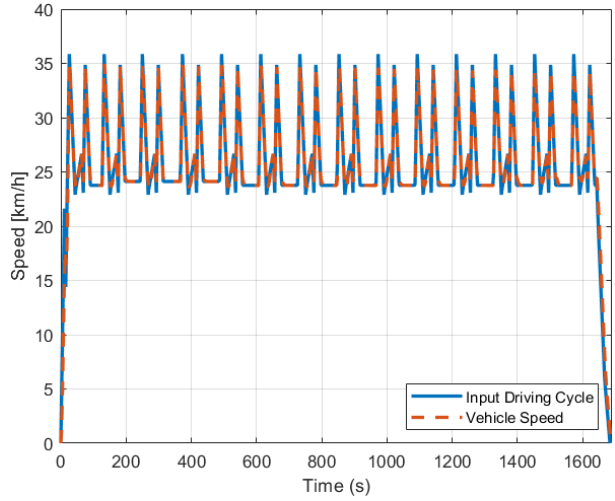
Figure 9. The competition reference driving cycle and the simulated vehicle model speed. By integrating the product between the current required by the motor and the voltage obtained in Equation (7), it is possible to extract the energy consumption for the fixed-ratio transmission model and for the CVT as shown in Figure 10. As shown, the simulated model with the designed CVT consumed 10.54% less energy than the simulated model with the fixed transmission ratio. This result validates the variable transmission’s development efforts and demonstrates the concept’s potential for battery consumption reduction.